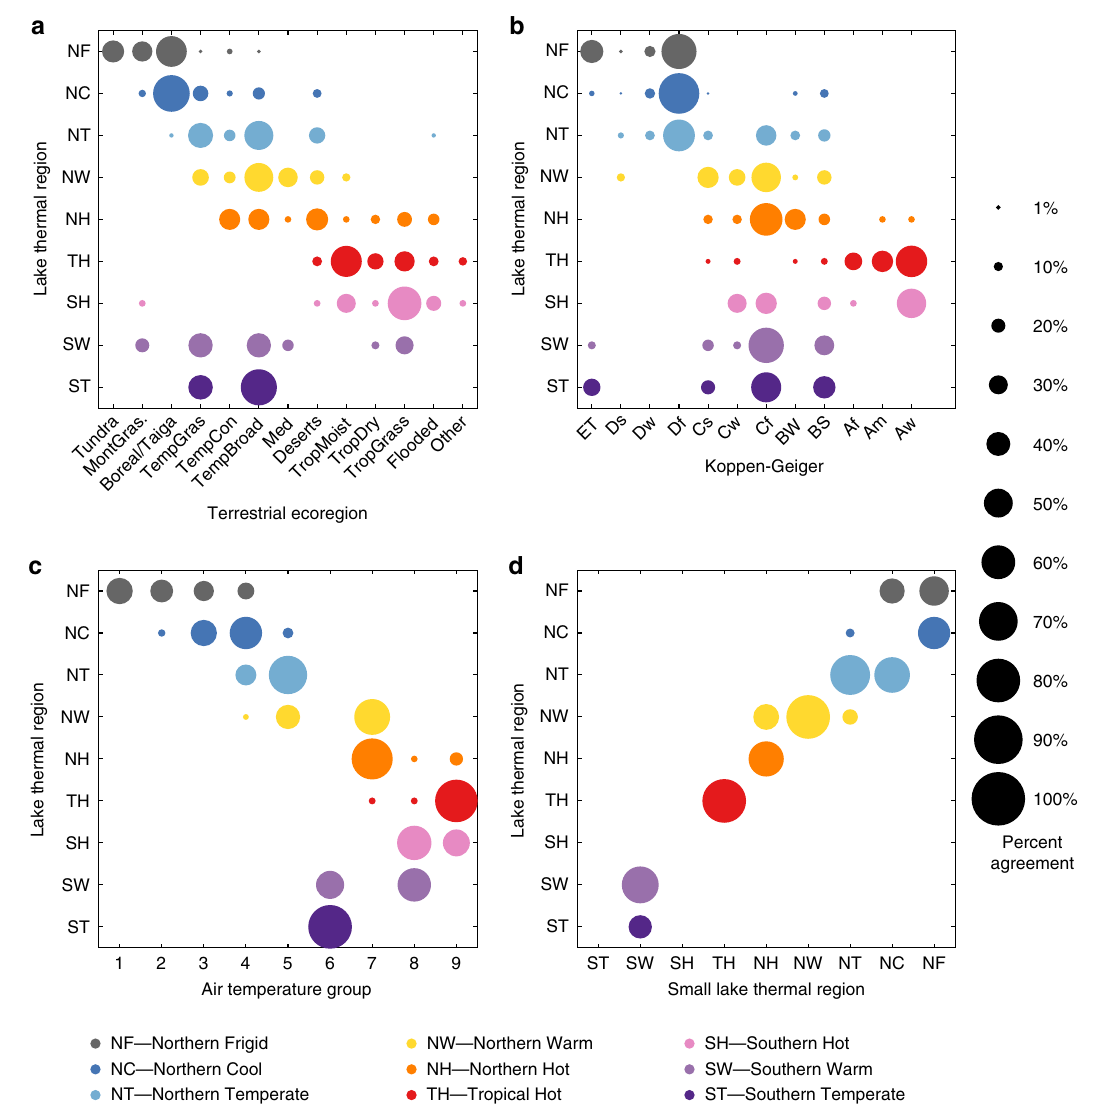
Fig. 3 Relationship between thermal regions and other global patterns. a Terrestrial ecoregions of the world (see ref. 24 Supplementary Table 2). b Koppen – Geiger binomial categories (see ref. 13 Supplementary Table 2). c Air temperature categories (see methods). d Data from small lakes ( x -axis) compared to geographical location ( y -axis) based on the global thermal regions identi fi ed from the lake model forced with ERA-Interim (Supplementary Table 3). The colours represent the lake thermal regions (as shown in Fig. 1) and the size of the circle the percent of lakes from a thermal region across the categories of the other